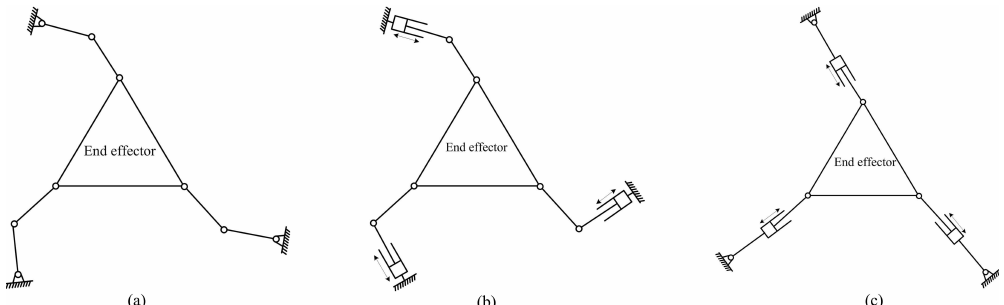
Figure 2. The typical planar parallel 3-DOF kinematic